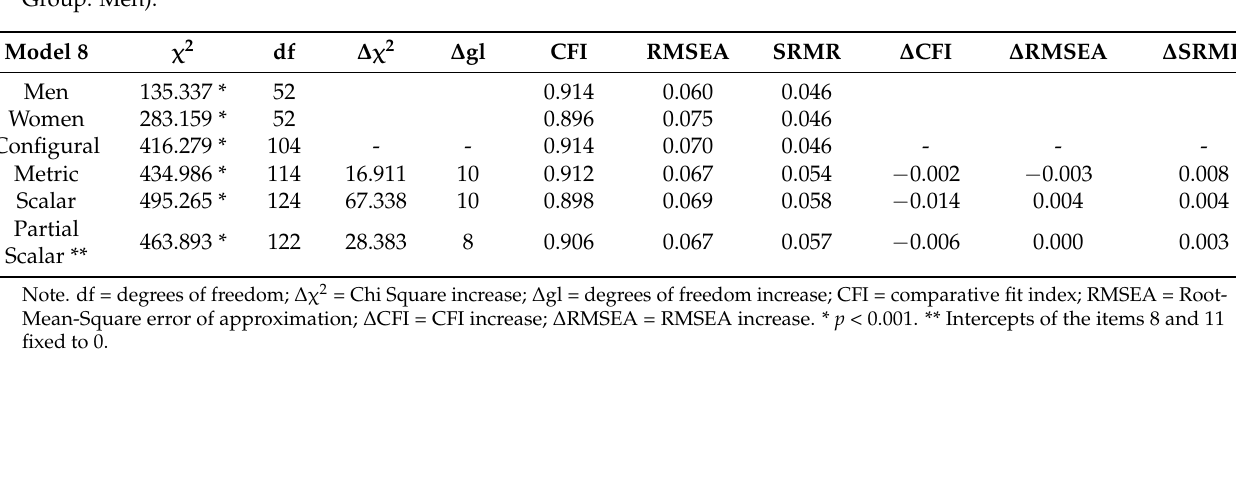
Figure 1. Path diagram and standardized loadings of model 8 for the Scale of Positive and Negative Experience (SPANE), with two correlated factors and item 13 (temeroso)(afraid) replacing item 9 (asustado) (afraid). Table 2. Gender-Based Measurement Invariance Models of the Scale of Positive and Negative Experience (SPANE) (Reference Group: